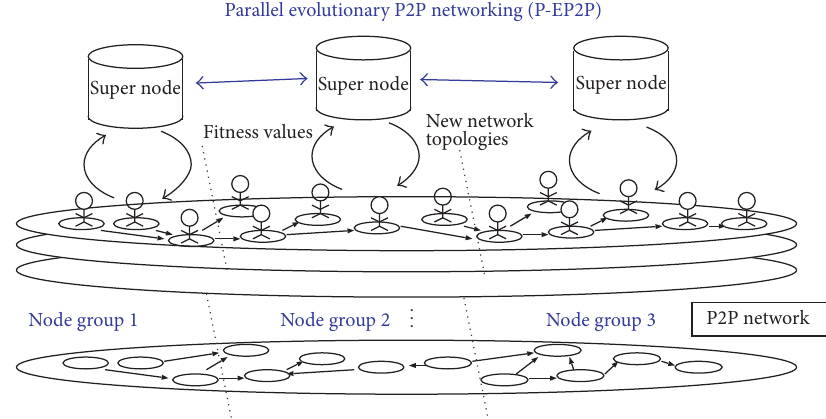
Figure 1: Overview of the parallel evolutionary P2P networking